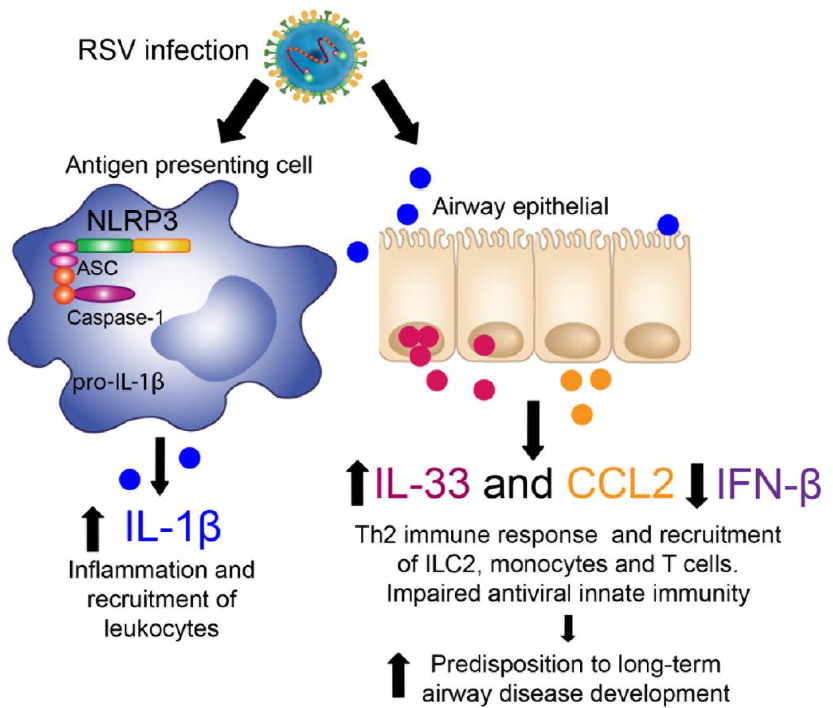
Figure 8. RSV induces NLRP3-inflammasome activation and leads to Th2 response. RSV infection activated NLRP3-inflammasome in Antigen presenting cells (APC), that trigger the production of IL-1β. Airway epithelial cells increases the expression of IL-33 and CCL2 when IL-1β is upregulated and downregulated IFNβ. IL-33 and CCL2 can recruit ILC2, monocytes, APC and T cells to the lung and increase the predisposition to airway disease development later in life.